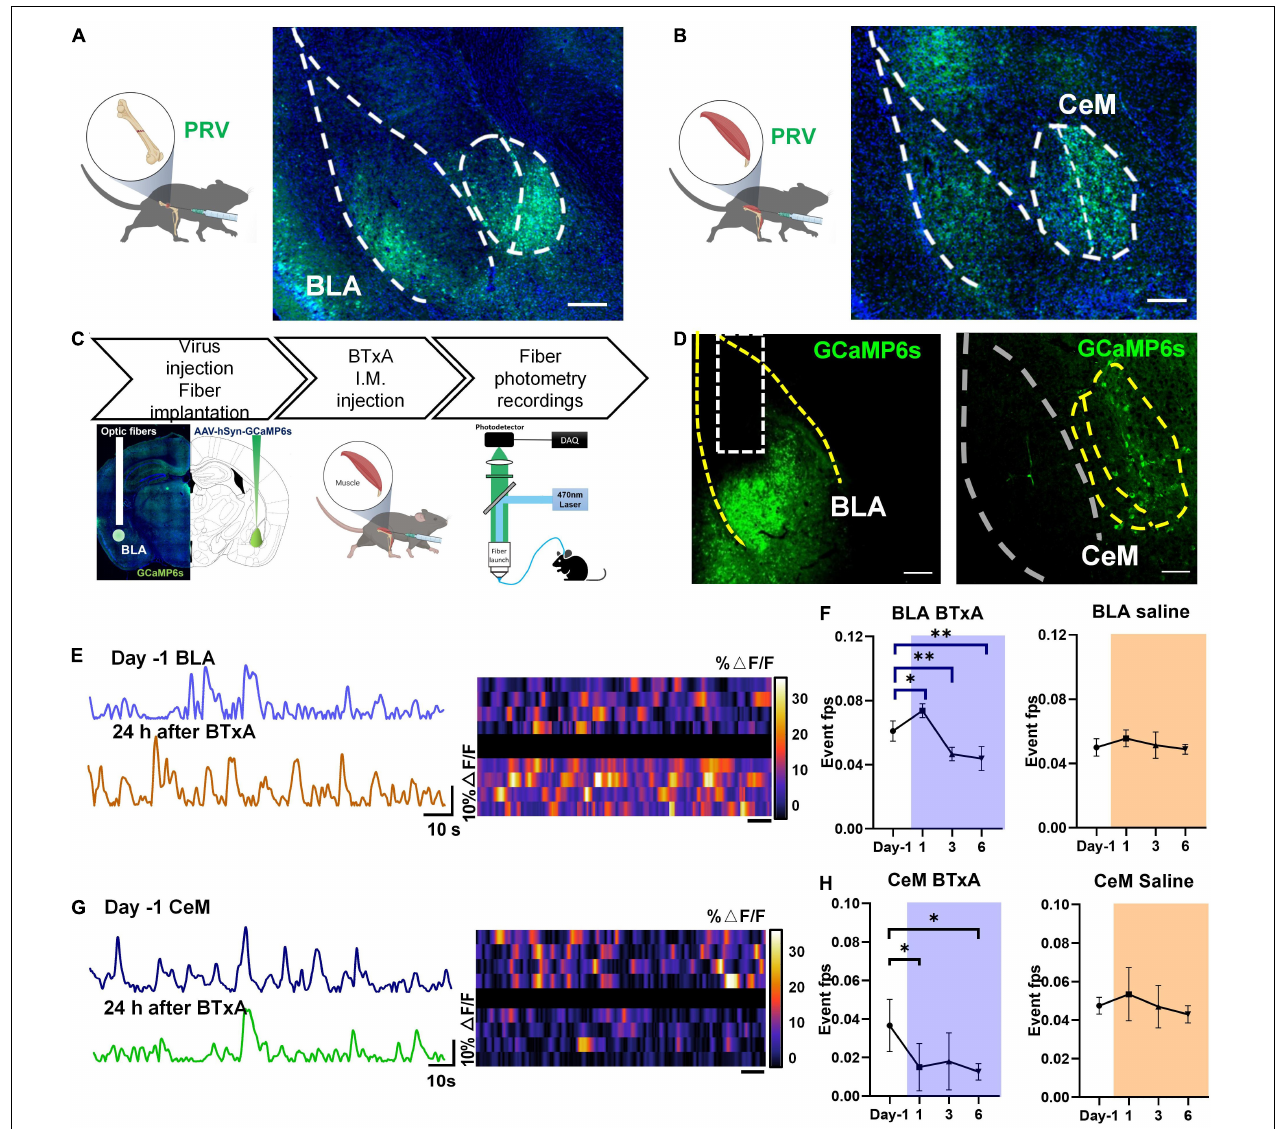
FIGURE 2 | Neural responses to mechanical loading in amygdala. (A) Retrograde tracing using pseudorabies virus (PRV) in femur of C57 mice; right, confocal microscopy image of PRV-labeled neurons in basolateral amygdala (BLA) and medial part of central amygdala (CeM). (B) Retrograde tracing using pseudorabies virus (PRV) in tibialis anterior of C57 mice; right, confocal microscopy image of PRV-labeled neurons in BLA and central amygdala. (C) Experimental procedure of in vivo fiber photometry after muscle dysfunction induced by BTxA treatment; (D) in vivo fluorescence images of AAV9-FLEX-GCaMP6f injected into BLA (left) and CeM (right). Scale bar, 100 µ m. (E) Examples of fiber photometry in the BLA followed with BTxA i.m. injection within 24 h (left); right, heat map of color-coded changes of fluorescence intensity in the mice as described in panel (E) . (F) Firing frequency of BLA neurons in response to BTxA i.m. injection or saline within 24 h, 3 days, and 6 days. (G) Examples of in fiber photometry in the CeM followed with BTxA i.m. injection within 24 h (left); right, heat map of color-coded changes of fluorescence intensity in the mice as described in panel (G) . (H) Firing frequency of CeM neurons in response to BTxA i.m. injection or saline within 24 h, 3 days, and 6 days. All data represent as mean ± SD. N = 5 (BTxA group), N = 4 (saline group); ∗ p < 0.05, ∗∗ p < 0.01; one-way ANOVA and Tukey comparisons Test were